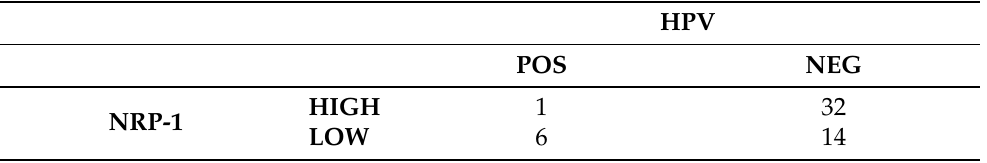
Table 5. Contingency table of NRP-1 expression by HPV positivity in OPSCC tumor samples (total n = 53). The chi square statistic is 7.9016, and the p -value is 0.004939. Significance at